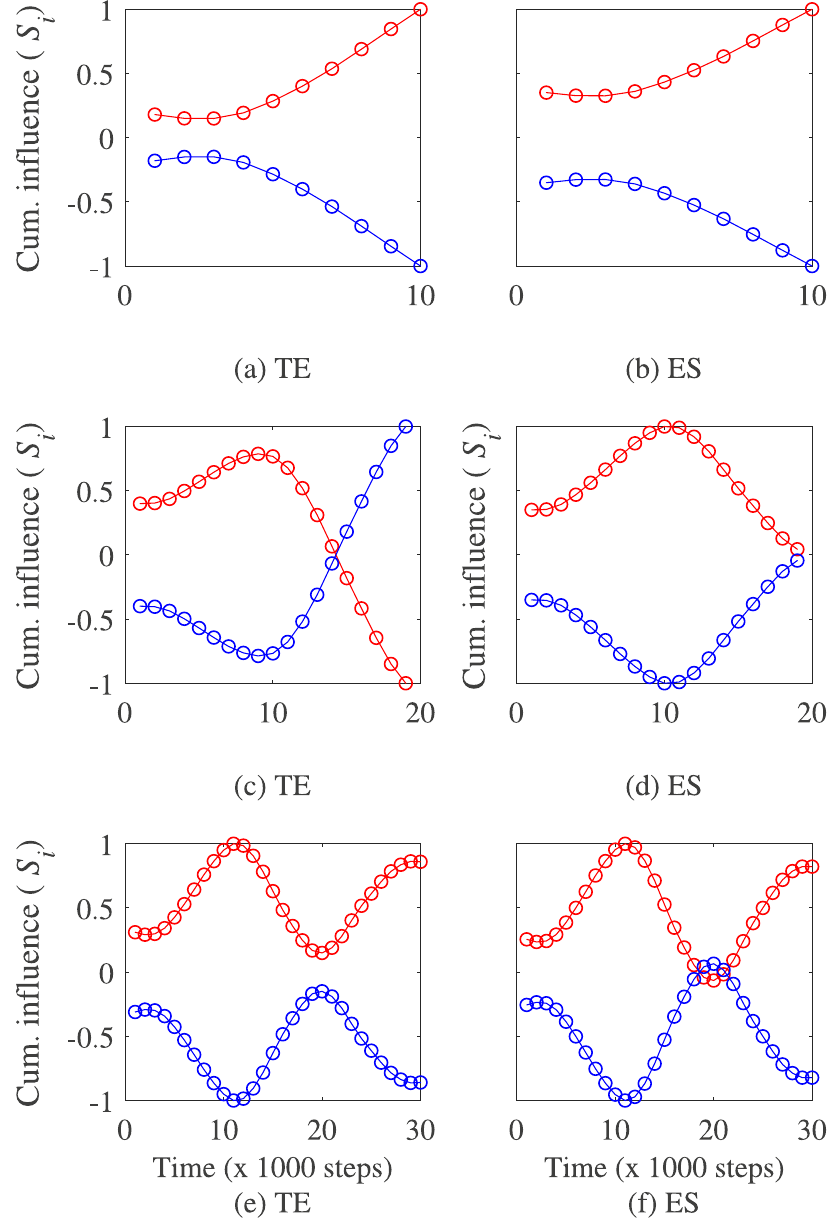
Figure 4. Illustration of switching leadership detection on simulated Vicsek particles with ( a , b ) constant leadership, ( c , d ) a single switching leadership event, ( e , f ) two leadership switching events. Left plot indicates the influence of individual 1 on individual 2 and right plot is the influence of 2 on 1. Note that the values of the cumulative influence ( S i ) are normalized between − 1 and 1. Model parameters for the simulations are N = 2, K = 2, v = 0.05, η = 0.2, and the switching events are set at 10,000 and 20,000 time steps after discarding the first 10,000